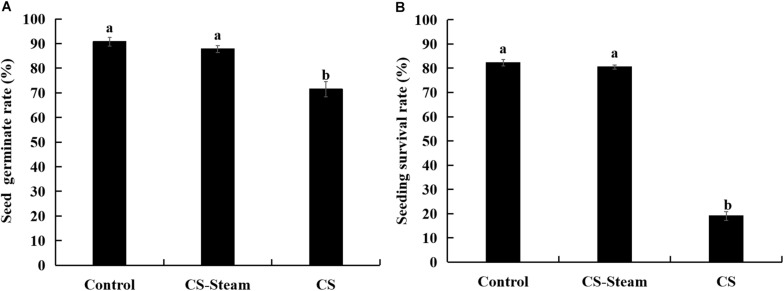
Seed germination (A) and seedling survival rate (B) of sanqi in continuously cultivated soil and uncultivated soil. Control represents the uncultivated sanqi soil, CS indicates the continuously cultivated soil with sanqi, CS-steam indicates the CS was treated with steam at 90°C for 15 min. The values represent the means ± SE. Different letters on the bars indicate significant differences between different treatments (p < 0.05; n = 3).